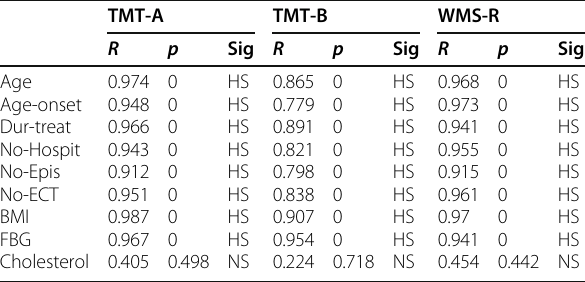
Table 3 Correlation between patients ’ cognitive functions and clinical